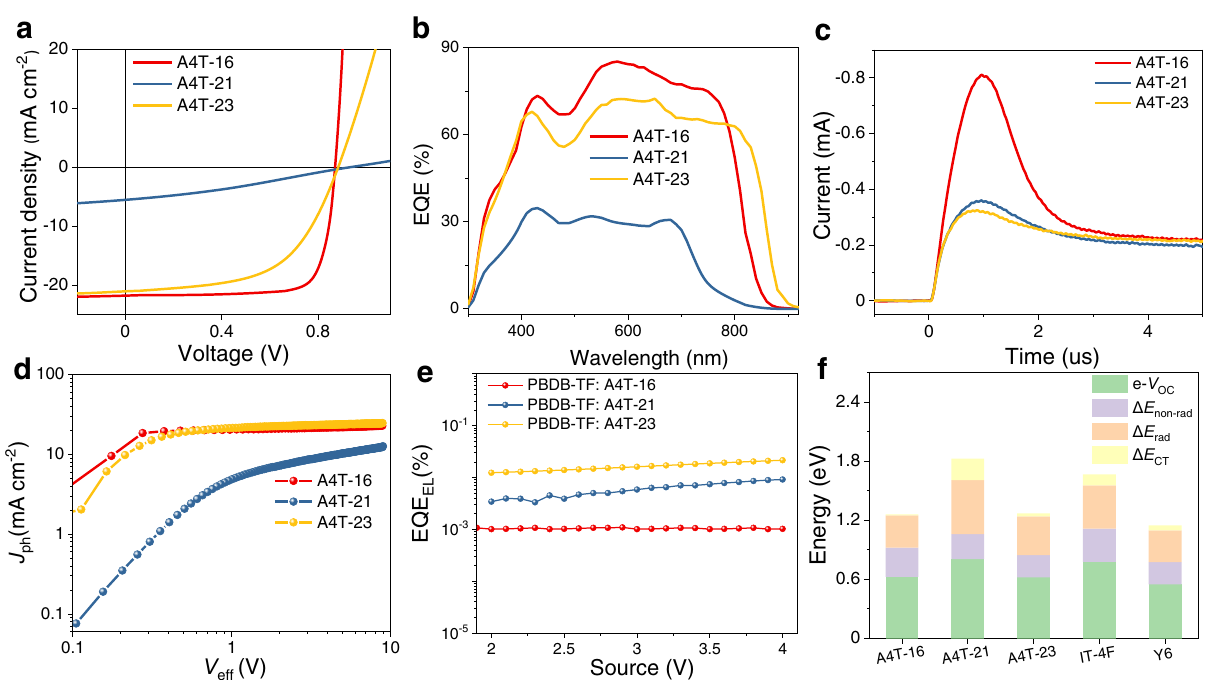
Fig. 5 Photovoltaic properties, and recombination mechanism of the OPV cells. a J − V curves, b EQE curves, c (Photo-CELIV) measurements for the mobilities of the fast carrier, d J ph − V eff curves, e EQE EL curves of A4T-16-, A4T-21-, and A4T-23-based cells. f Energy losses of A4T-16-, A4T-21-, A4T-23-, IT-4F-, Y6-based